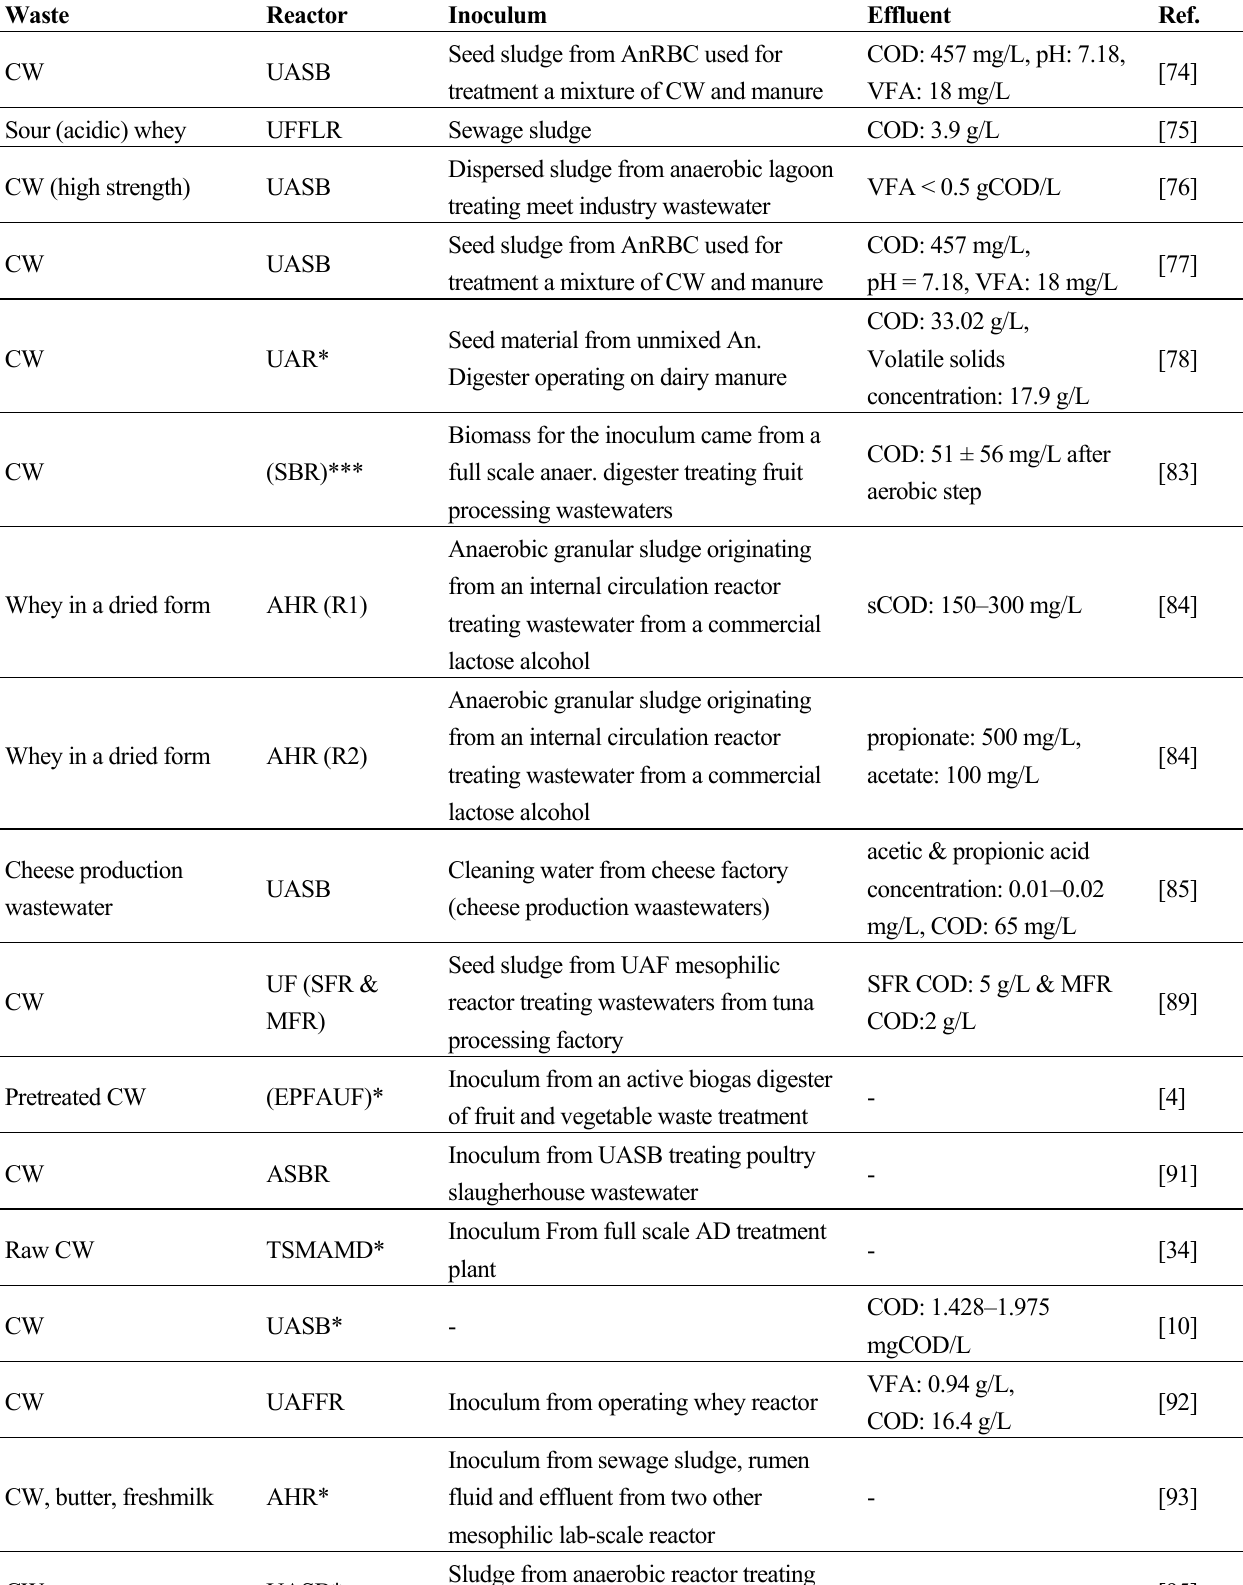
Table 4. Inocula and effluent concentration of CW AD